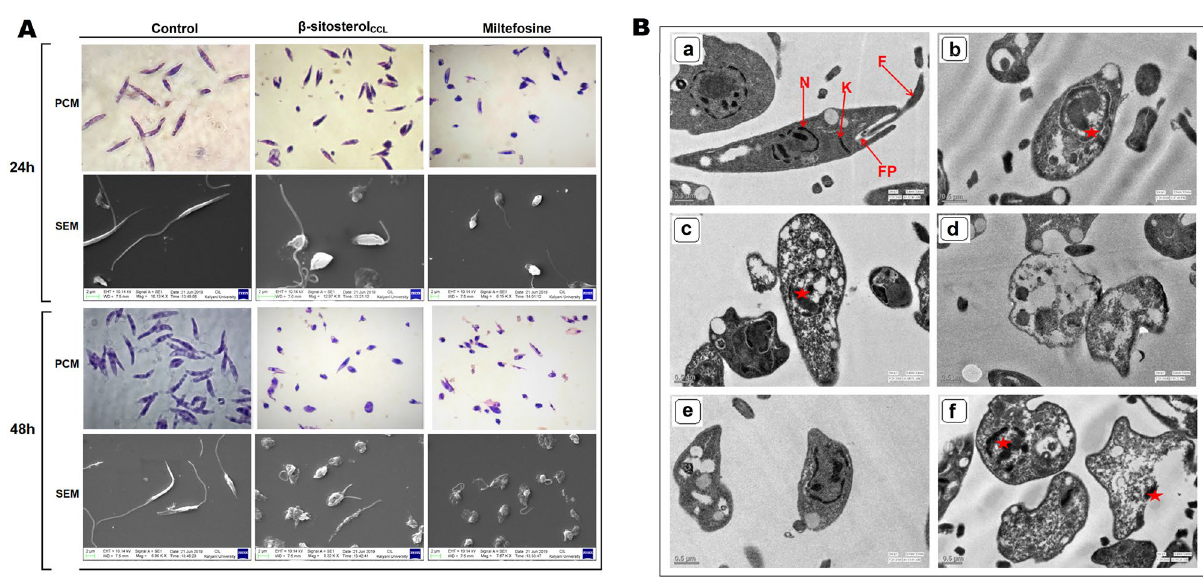
Figure 5. ( A ) Morphological study of L. donovani promastigotes. Phase contrast microscopy (PCM) and scanning electron microscopy (SEM) results depicting morphological alterations in β-sitosterol CCL (IC 50 dose)- treated promastigotes (1 × 10 7 /ml) for 24 h and 48 h compared to control cells. SEM scale bars = 2 μm. ( B ) TEM results showing ultrathin sections of L. donovani promastigotes. Promastigotes (1 × 10 7 /ml) were treated with β-sitosterol CCL (IC 50 dose) for 24 h and 48 h. ( a) Untreated control, ( b ) β-sitosterol CCL -treated promastigotes for 24 h, ( c , d ) β-sitosterol CCL -treated promastigotes for 48 h, ( e ) miltefosine (10 µm)-treated promastigotes for 24 h, ( f ) miltefosine (10 µm)-treated promastigotes for 48 h. N, nucleus; K, kinetoplast; F, flagellum; FP, flagellar pocket. Scale bar = 0.5 μm. In treated cells, the star (red) indicates the vacuolated